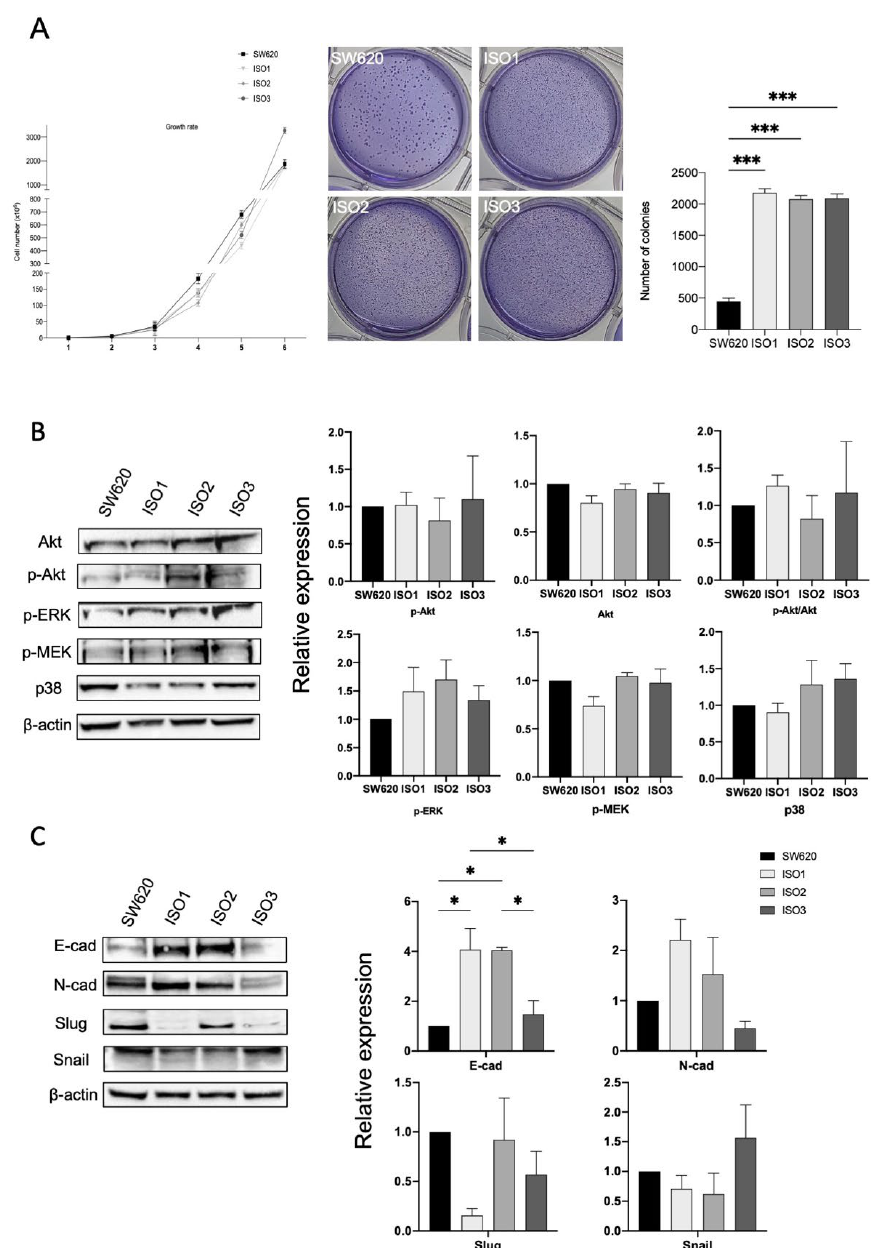
Figure 4. Lonp1 isoforms can affect cancer development and progression. ( A ). Graph showing the growth rate of SW620 and cells overexpressing Lonp1 isoform-1, isoform-2, and isoform-3 (on the left). Soft agar colony formation assay of SW620 and cells overexpressing Lonp1 isoform-1, isoform-2, and isoform-3 (in the middle). Histogram showing the number of colonies, from soft agar colony formation assay, of SW620 and cells overexpressing Lonp1 isoform-1, isoform-2, and isoform-3 (on the right). Data are reported as mean ± SD of two independent experiments. ( B ). Representative immunoblots showing Akt, P-Akt, P-ERK, P-MEK, and p38 expression in SW620 and cells overexpressing Lonp1 isoform-1, isoform-2, and isoform-3 (on the left). Histograms showing the relative expression of Akt, P-Akt, P-Akt/Akt, P-ERK, P-MEK, and p38 in the same cell lines (on the right). Data are reported as mean ± SD of three independent experiments. ( C ). Representative immunoblots showing E-cad, N-cad, Slug, and Snail expression in SW620 and cells overexpressing Lonp1 isoform-1, isoform-2, and isoform-3 (on the left). Histograms showing the relative expression of E-cad, N-cad, Slug, and Snail in the same cell lines (on the right). Data are reported as mean ± SD of three independent experiments. * = p < 0.05; *** = p <